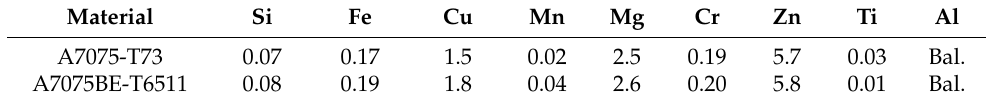
Table 1. Chemical compositions of the materials used in the experiments (wt%).